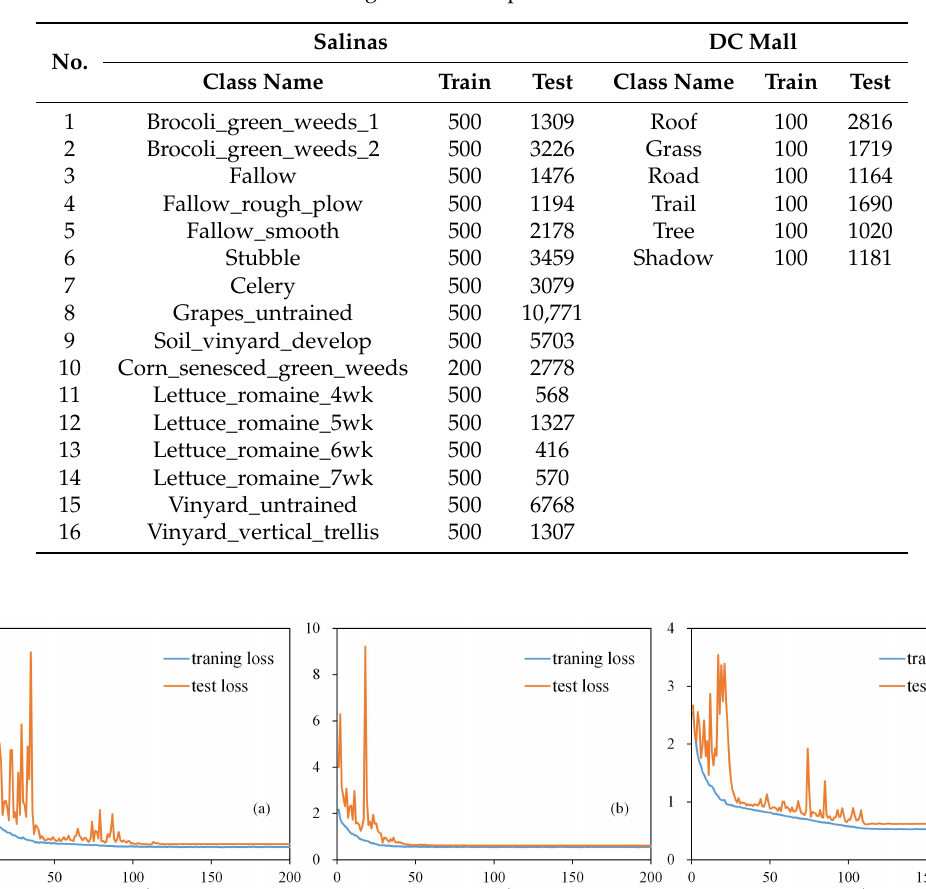
Figure 13. The DC Mall scene: ( a ) false-color composite image; ( b ) ground truth. Table 7. The number of training and test samples for Salinas and DC Mall datasets.